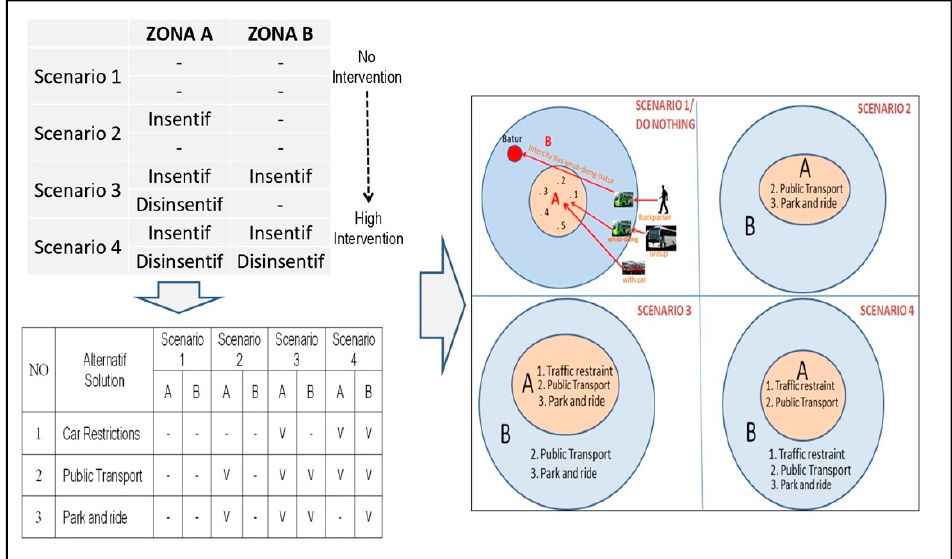
Figure 6. Transportation policy intervention scenario in the tourism zones .